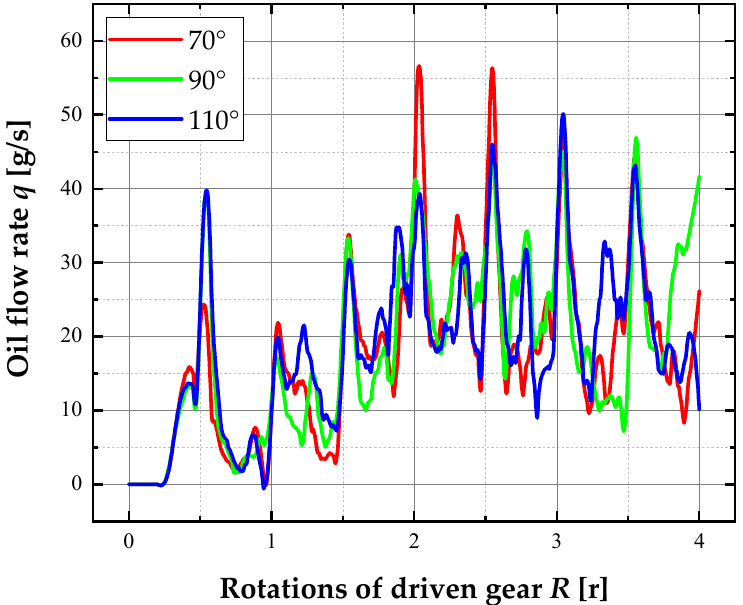
Figure 11. Oil flow rate of the meshing area at various angles of oil-guiding tube. With various driven gear speeds, the lubricating oil flow rate in the gear-meshing area can be seen in Figure 12 under the action of the oil-guiding tube. The average flow rates of V = 400 r/min, 600 r/min, and 800 r/min are 11.6 g/s, 18.4 g/s, and 28.9 g/s, respectively. The lubricating oil flow rate in the gear-meshing area has increased significantly. It can be deduced from this that increasing the rotational speed of the driven gear can improve the drainage effect of the oil-guiding tube, leading to a significant increase in the amount of lubricating oil that flows through the gear-meshing area.